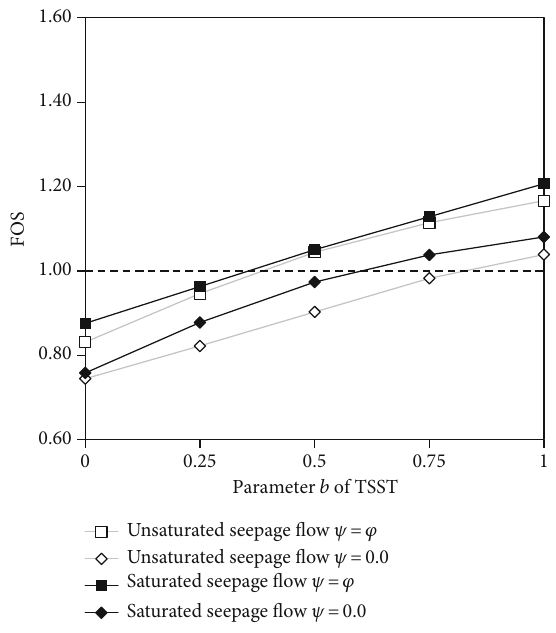
Figure 4: Relation between FOS and parameter b when the underground water level rises to the slope